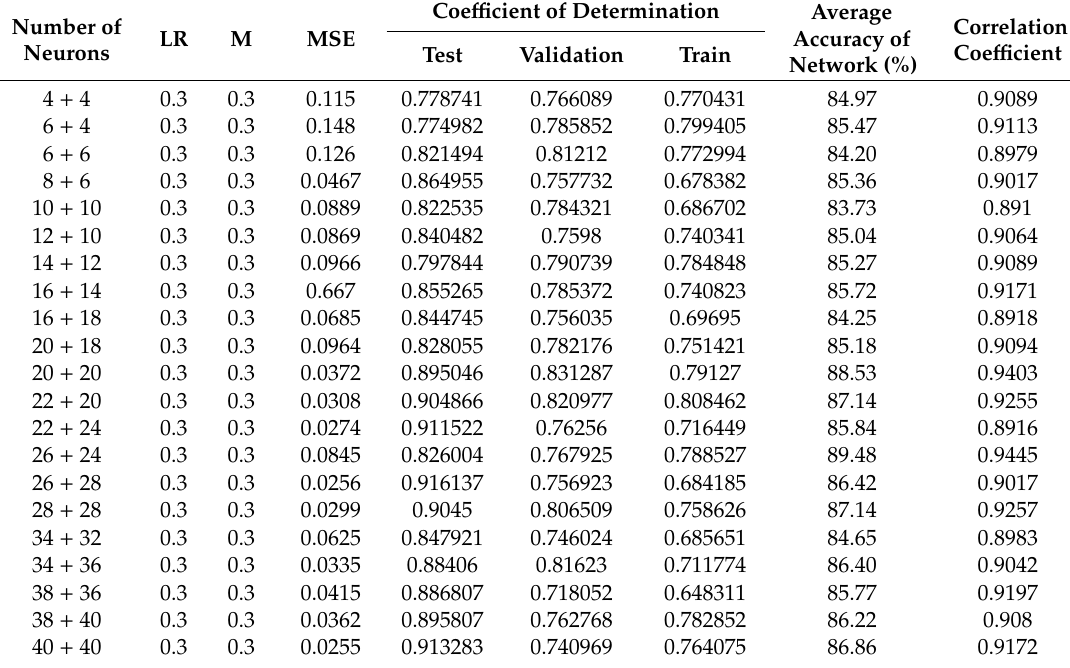
Quantitative indicators for evaluating networks developed using scaled conjugate gradient